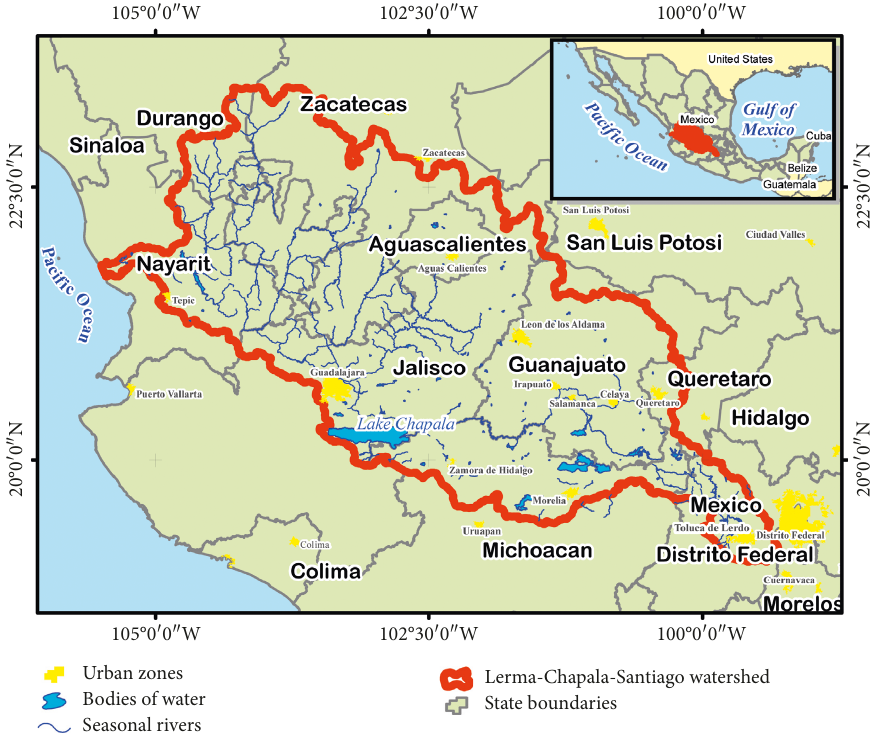
Figure 1: Location of the Lerma-Chapala-Santiago watershed in